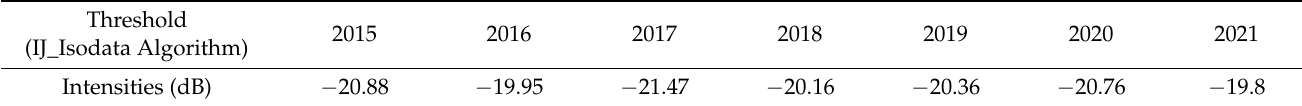
Figure 4. GEI 2017 ( a ), 2018 ( b ), detected changes from GEI 2017–2018 ( c ). VV polarization in 2017 ( d ), 2018 ( e ), detected changes from VV 2017–2018 after applying the threshold values ( f ). VH polarization in 2017 ( g ), 2018 ( h ), detected changes from VH 2017–2018 after applying the threshold values ( i ). Table 3. Threshold values for time-series VH